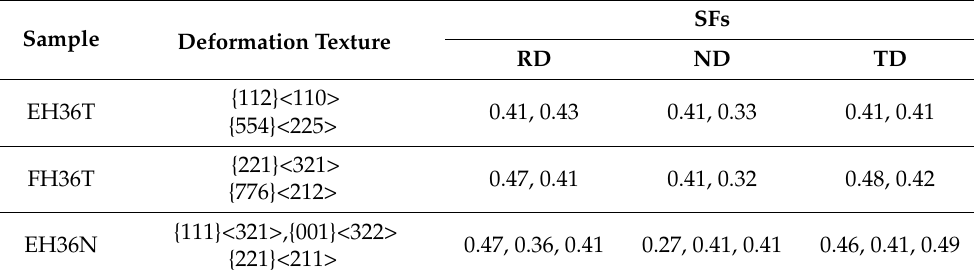
Table 5. SFs of the typical deformation textures of the rolled offshore structural steels.